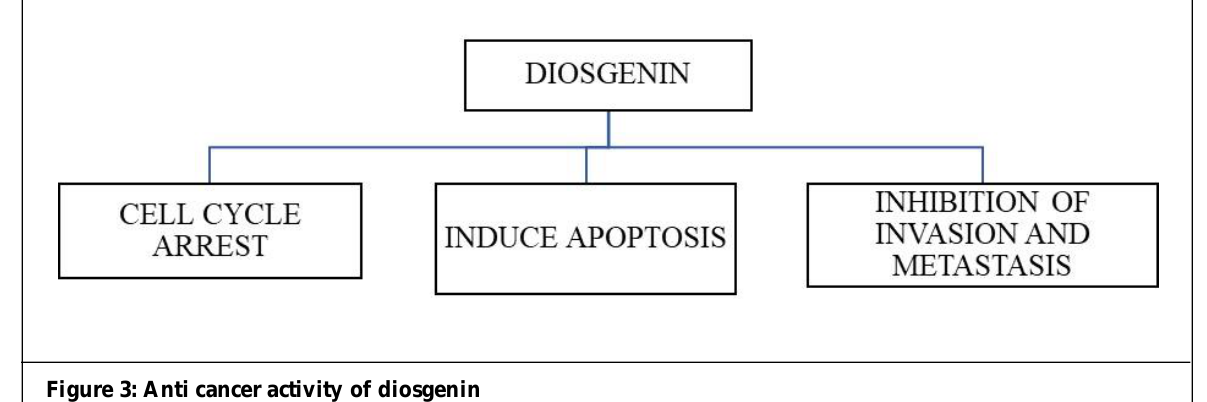
Figure 3: Anti cancer activity of